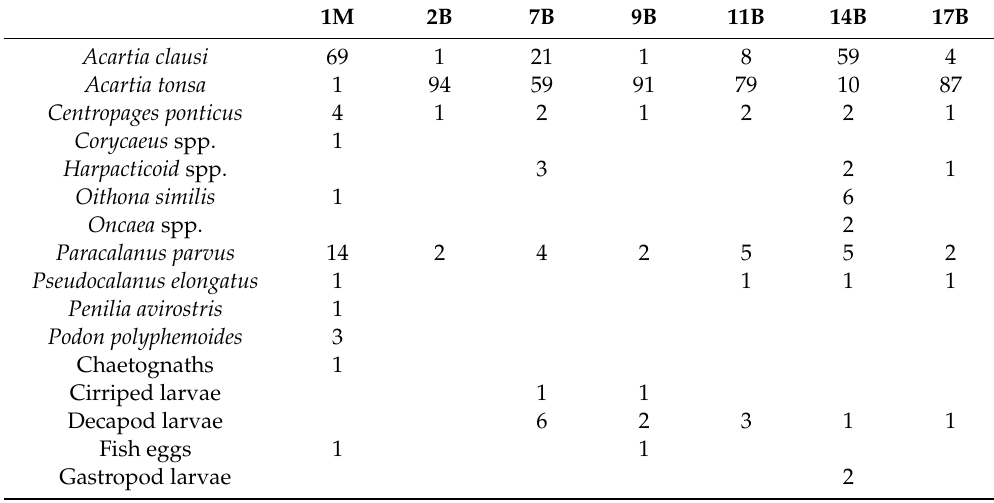
Table 3. Mean percentage contributions of the most abundant species / taxa at the seven stations for the 2003–2004 period.